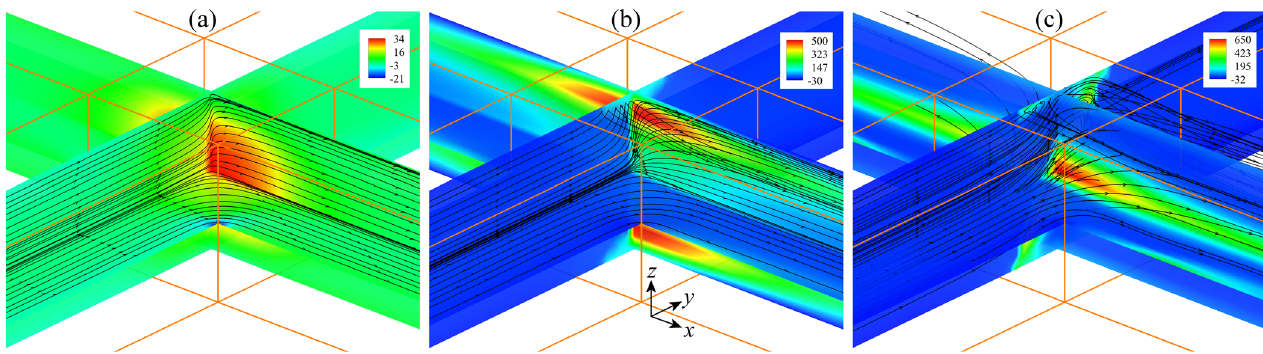
FIG. 14. Contours of the normalized first normal stress difference N 1 = ð η 0 U=w Þ (indicated by the color scale) with superimposed streamlines along the center planes of the cross slot. Constant elasticity number simulations using the FENE-MCR model with ¼ 0 . 02 , Re ¼ 4 . 76 (symmetric), (b) Wi ¼ 0 . 08 , Re ¼ 19 . 05 (symmetric), and (c) Wi El ¼ 0 . 0042 , β ¼ 0 . 90 and (a) Wi eff eff Re ¼ 29 . 76